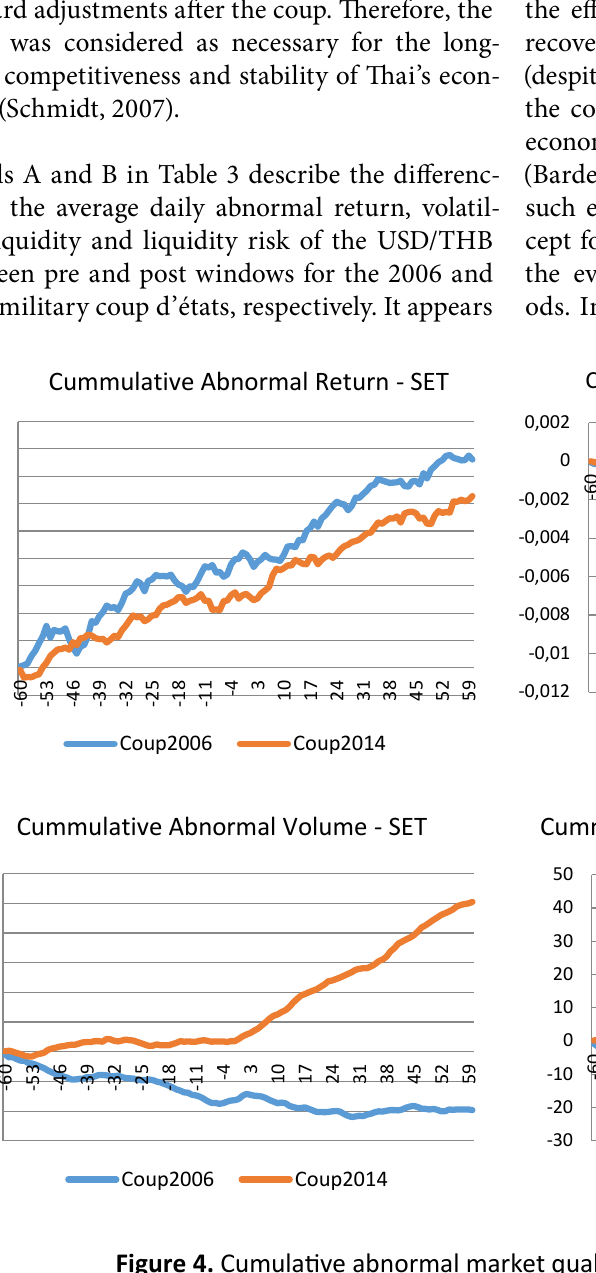
Figure 4. Cumulative abnormal market quality in the Thai stock market